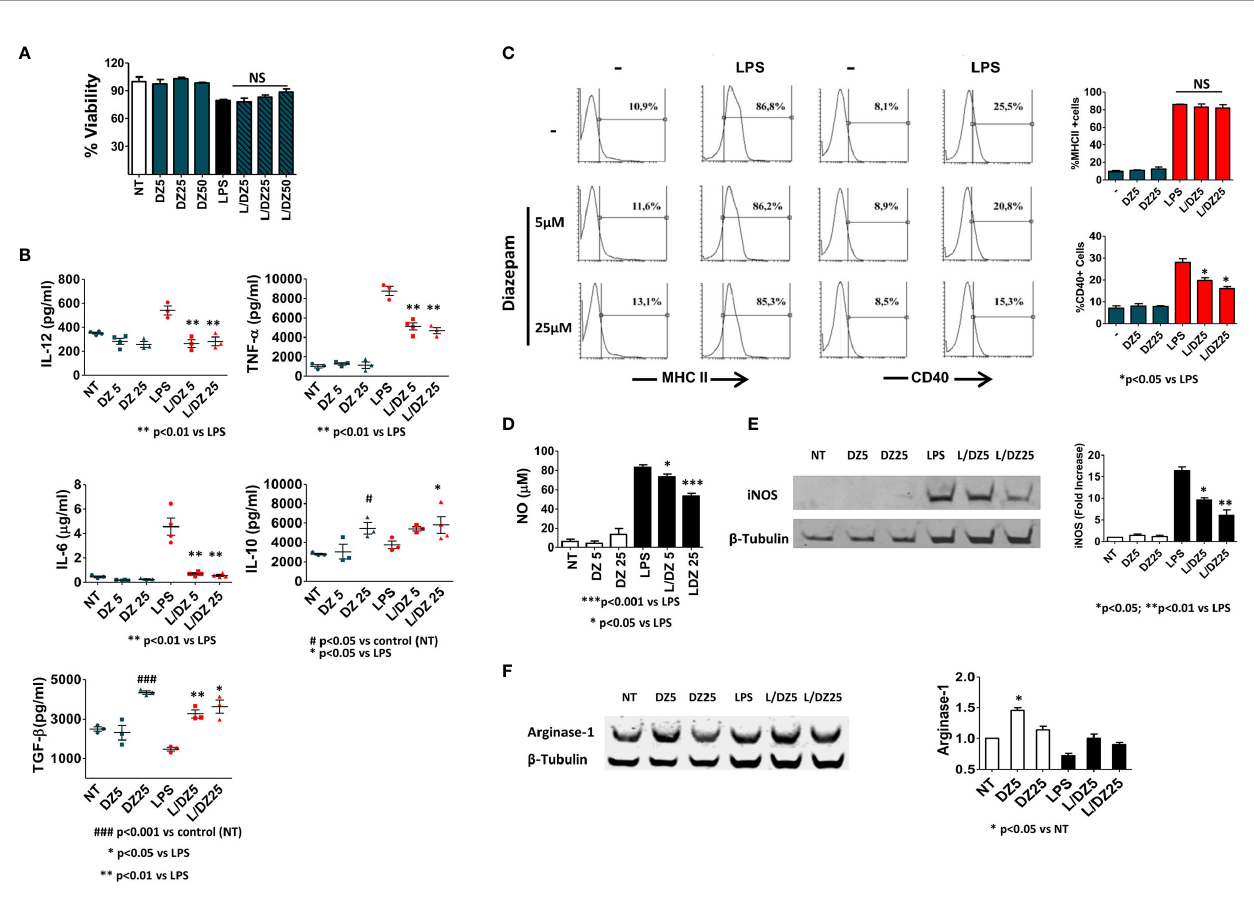
FIGURE 1 | Diazepam (DZ) inhibits classical activation in macrophages cultured with LPS. C57BL/6 bone marrow-derived macrophages (4 × 10 5 cells in 200 µl) were incubated in the presence of LPS (1 µg/ml), and DZ (5 and 25 m M) and evaluated after 18 h of culture (A) Percentage of cell viability was assessed with the MTT technique, (B) the supernatant was collected and IL-12p70, TNF- a , IL-6, IL-10, and TGF- b production was determined by ELISA, (C) MHCII and CD40 positive cells were assessed on F4/80+ macrophage population by FACS analysis, (D) Production of nitric oxide (NO) was evaluated by Griess reaction, and (E, F) levels of inducible nitric oxide synthase (iNOS) and Arginase-1 were determined by Western blot. Signi fi cant differences vs. LPS-treated cells are indicated by * p < 0.05, ** p < 0.01, *** p < 0.001, and vs. nontreated cells (NT) by # p < 0.05 and ### p < 0.001. Non-signi fi cant values are expressed as NS. The graphs are representative of at least three independent